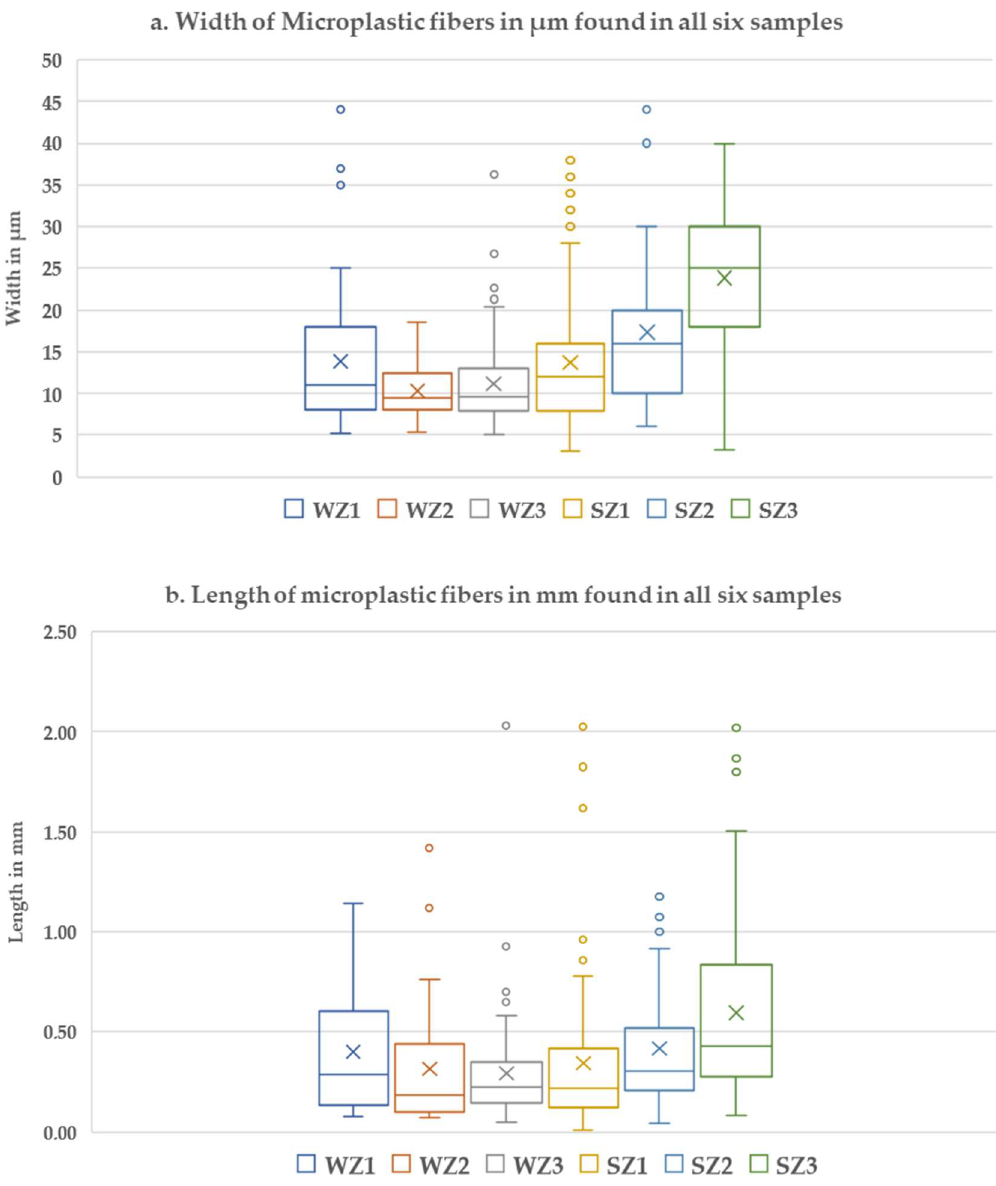
Figure 5. Width and length of microplastic fibers in µ m found in all six samples. Box plots depict range of width or length with top whisker equal to the 90th percentile, top of the box equal to the 75th percentile, bar at middle of box equal to the 50th percentile, bottom of box equal to the 25th percentile, and bottom whisker equal to the 10th percentile. Dots above the top of the whisker represent large width or length values that occur outside the quartiles represented, in which we can see fibers up to 45 µ m of width and up to 2000 µ m long. The number of microplastic fibers in each sample are Water Site 1 (WZ1: 53), Water Site 2 (WZ2: 31), Water Site 3 (WZ3: 72), Sediment Site 1 (SZ1: 82), Sediment Site 2 (SZ2: 36), and Sediment Site 3 (SZ3: 114). The X inside the boxes shows the average data for width (WZ1 14 µ m, WZ2 10 µ m, WZ3 11 µ m, SS1 14 µ m, SZ2 17 µ m, SS3 24 µ m) and length (WZ1 400 µ m, WZ2 300 µ m, WZ3 300 µ m, SS1 300 µ m, SZ2 400 µ m, SZ3 600 µ m). Graphic a shows the width of fibers, Graphic b shows the length of fibers.